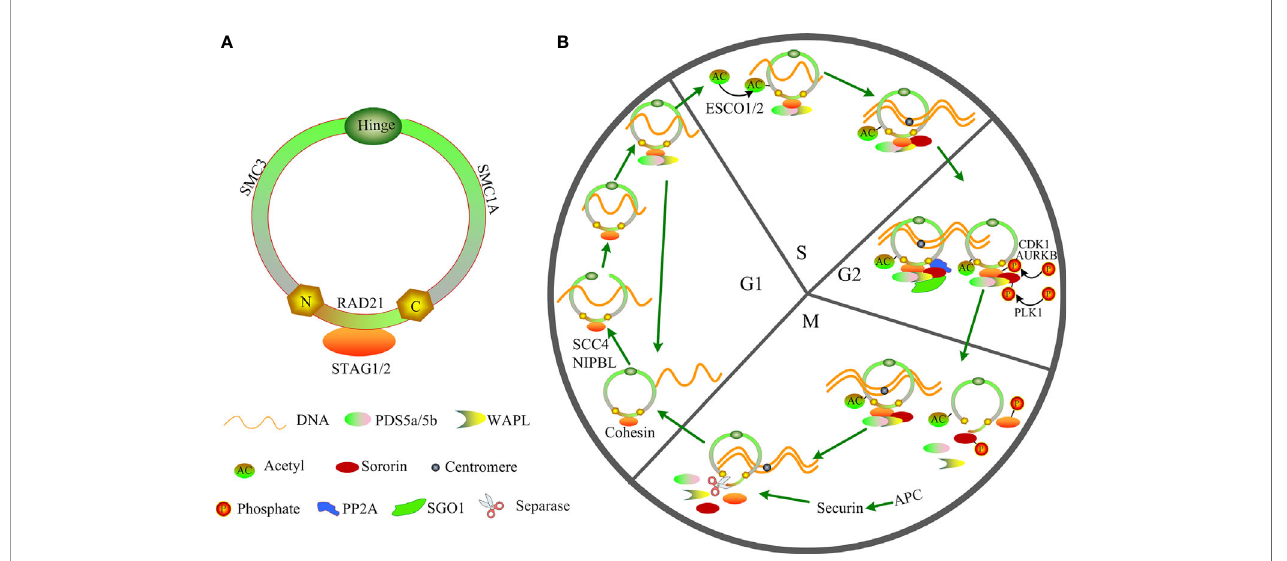
FIGURE 1 | Structure and function of cohesin in the cell cycle. (A) Structure of cohesin. (B) Function of cohesin in the cell